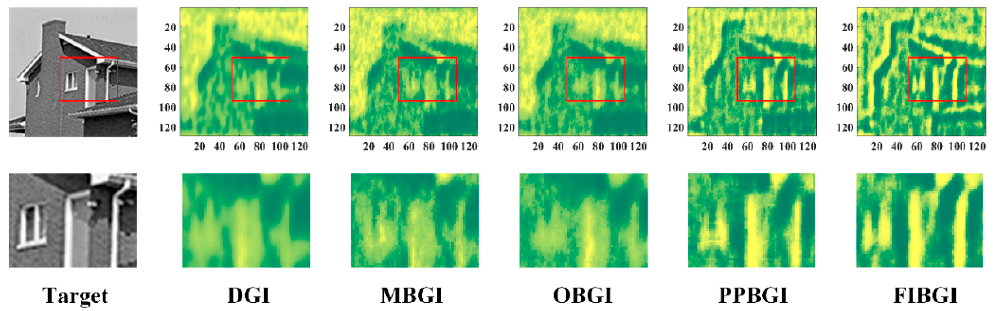
Figure 6. The reconstructed results of grayscale target with different methods.